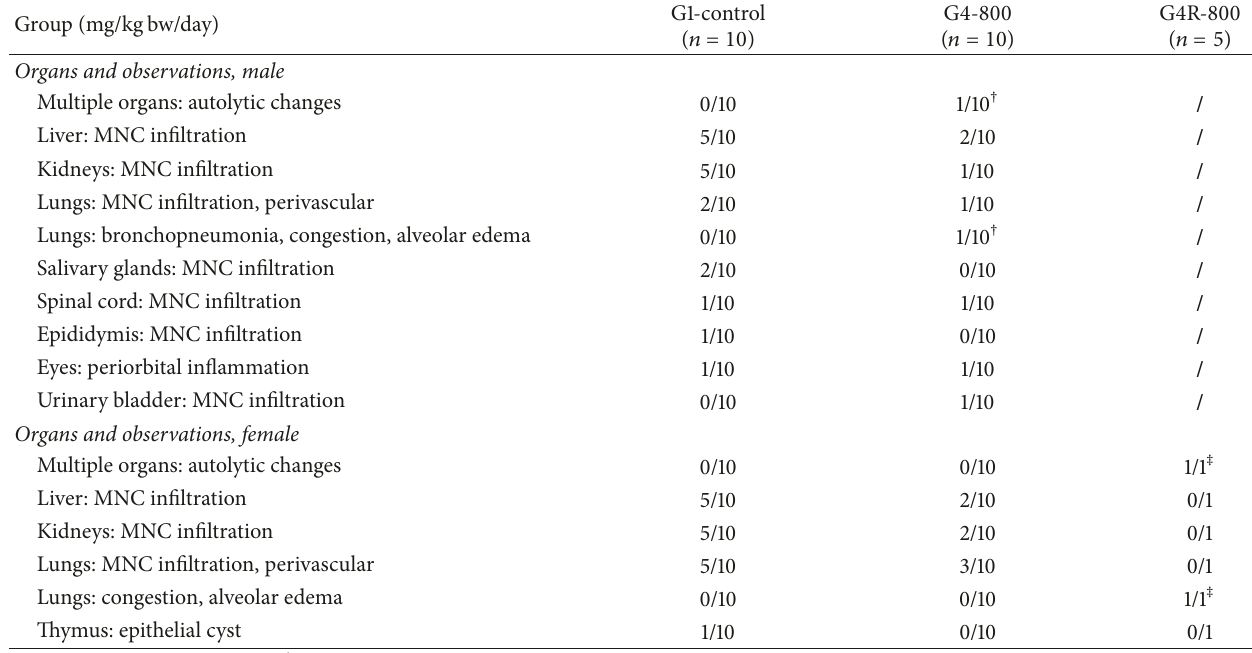
Table 9: Summary of histopathological